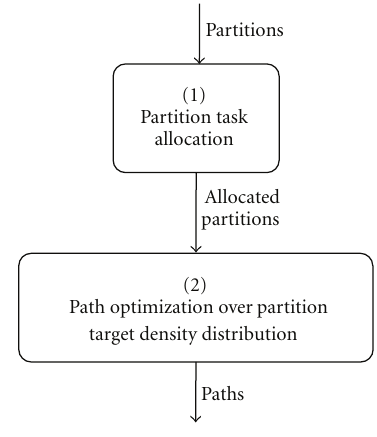
Figure 12: Structure of path planning decomposed into task allocation over partitions and path planning by optimizing directly over the target density